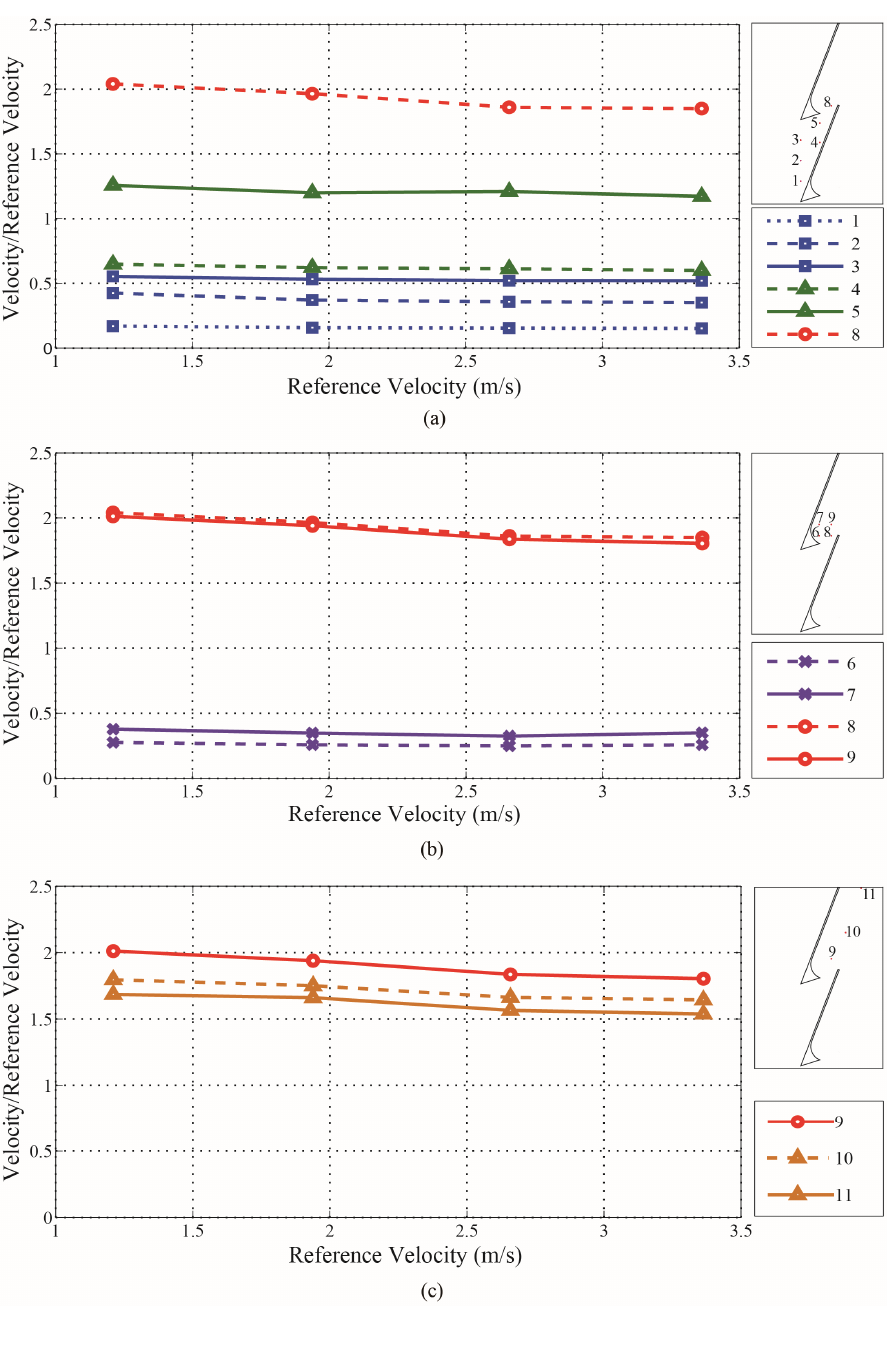
Figure 15. Wind velocity rate of the scaled guide vane model: ( a ) points before the rotor position; ( b ) points inside the rotor position; and ( c ) points after the rotor